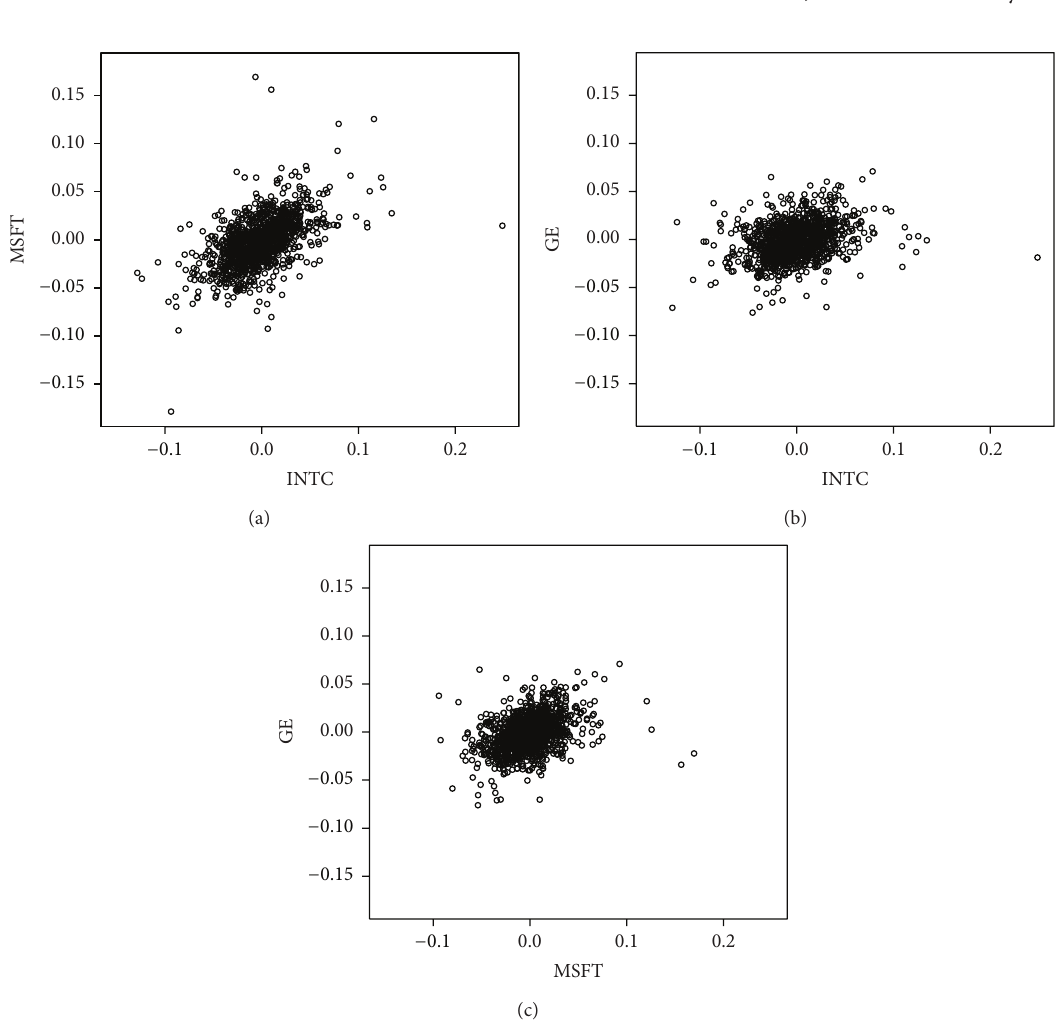
Figure 7: Left-to-right: scatter plots of (INTC, MSFT), (INTC, GE), and (MSFT, GE),